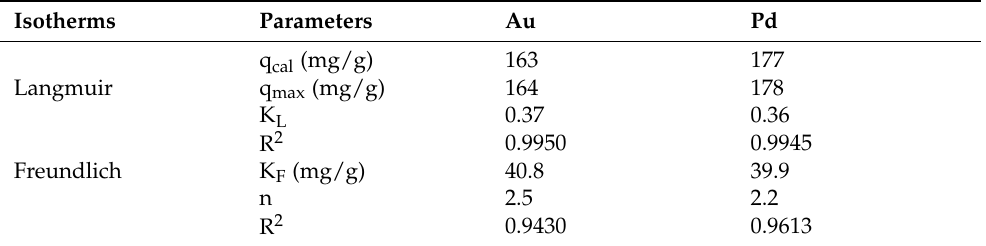
Table 3. Parameters of Langmuir and Freundlich isotherm models for adsorption of Au(III) and Pd(II) ions onto Zn–Al–LDH@ZIF–8 nanocomposite.